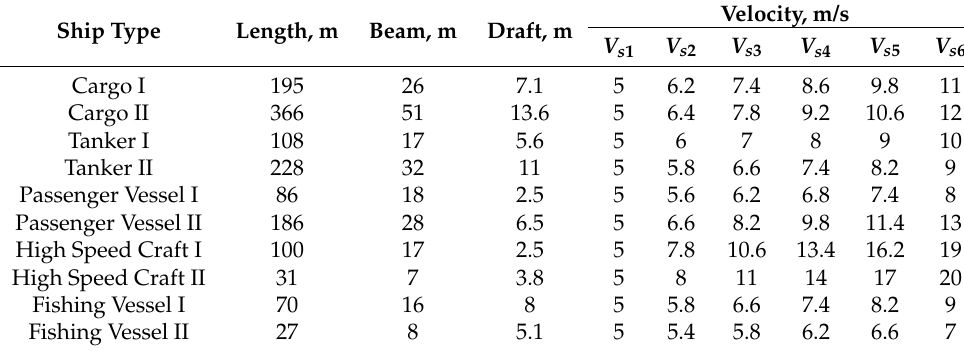
Table 1. Vessel parameters used for simulating ship